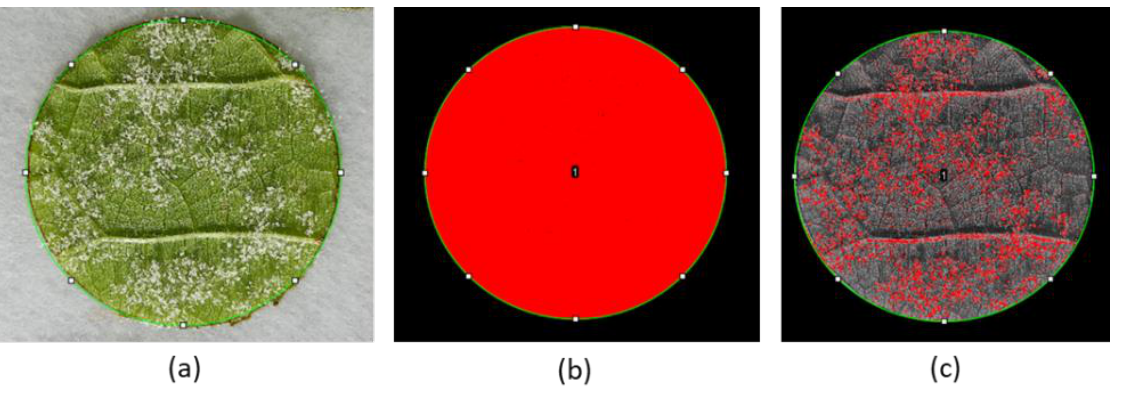
Figure 6. Image processing: ( a ) picture of a sporulating leaf disc, 7 days after inoculation with Plasmopara viticola sporangia; ( b ) the pixels of the entire disc are selected (red) and measured; ( c ) with the color threshold function, only the pixels of the white sporangia are selected (red) and measured.